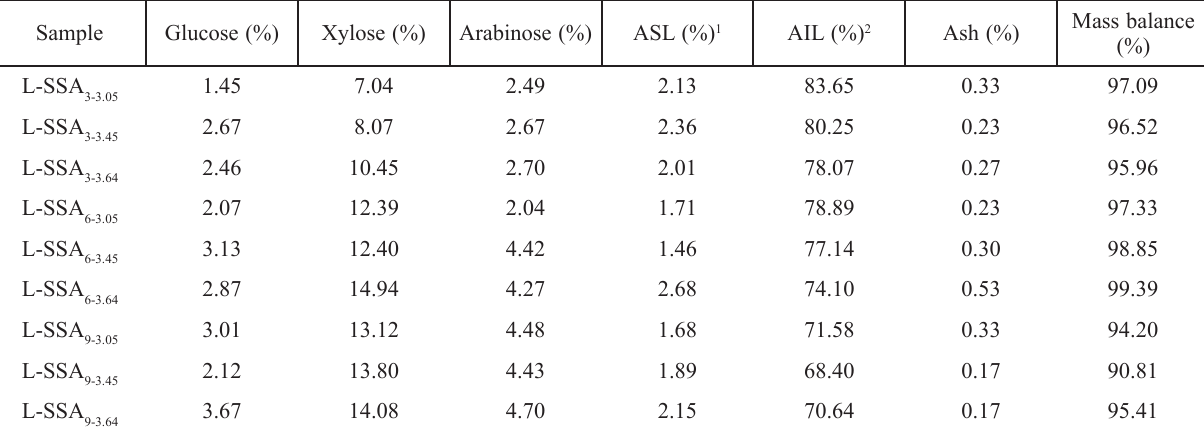
Table 1 – The lignin and carbohydrates content of L-SSA